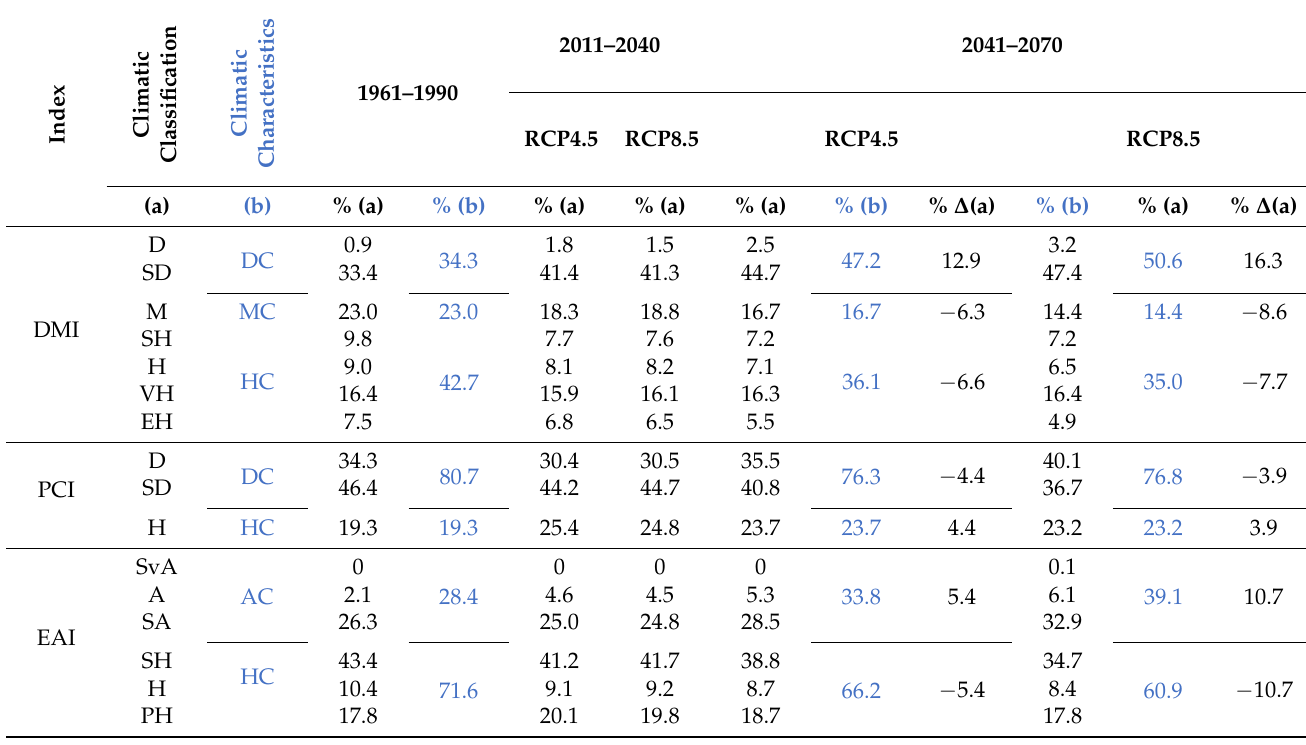
Table 3. Percentage of the territory for each climate of the De Martonne Aridity Index (DMI), the Pinna Combinative Index (PCI), and the Erinç Aridity Index (EAI) for 1961–1990 and 2011–2040 and 2041–2070 under RCP4.5 and RCP8.5 (note that ∆ = 2041–2070–1961–1990 in